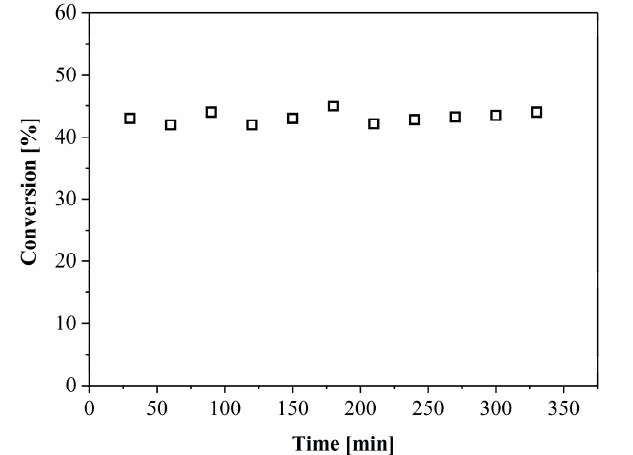
Figure 6. Conversion vs. time in the M1 ‐ A microreactor.